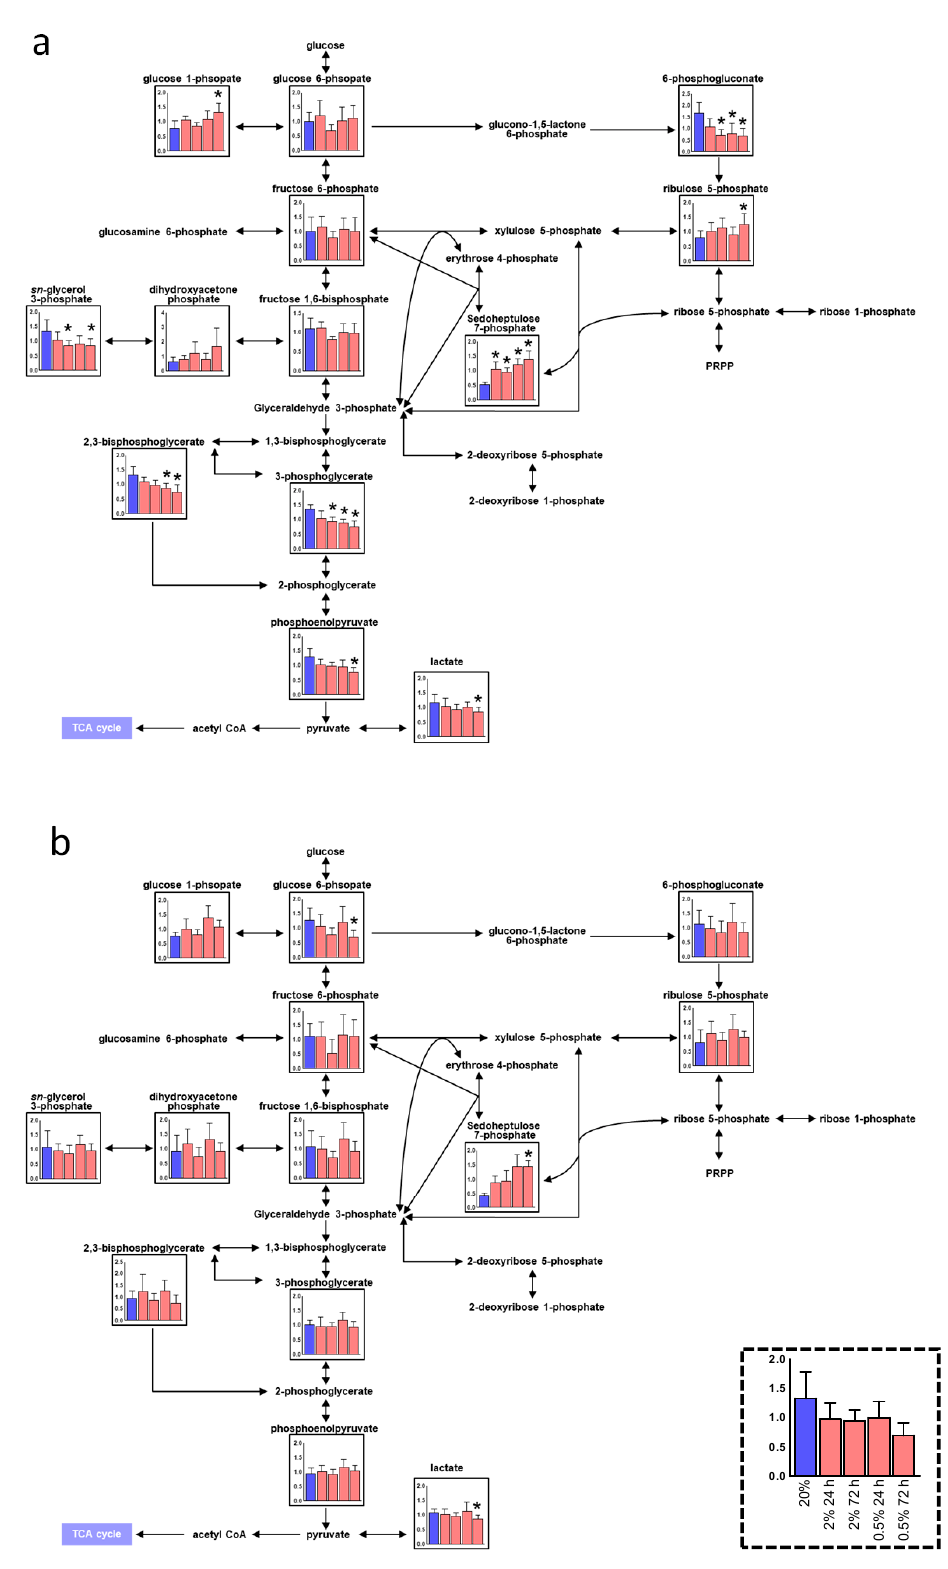
Figure 3. Metabolic pathways of glycolysis and pentose phosphate pathway (PPP) of oral keratinocytes ( a ) and oral fibroblasts ( b ) in hypoxic culture ( n = 6). Quantified metabolite concentrations are shown as bars; ambient oxygen cultured (blue), 2% O 2 for 24 h, 2% O 2 for 72 h, 0.5% O 2 for 24 h, and 0.5% O 2 for 72 h from the left, respectively. p -values were calculated using Student’s t -test (two-tailed, unequal variance). * p < 0.05 was shown for comparison between each data with data for 20%